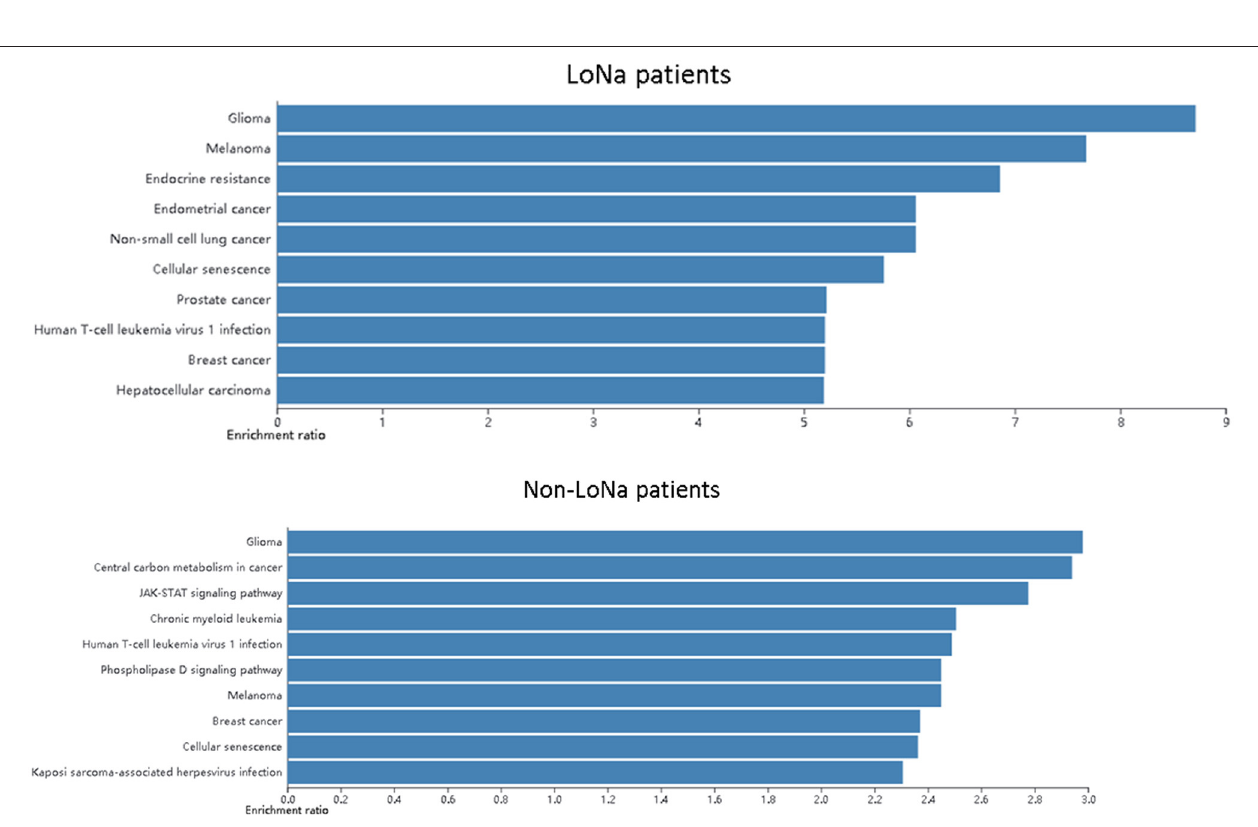
FIGURE 6 | Pathway analysis of LoNa patients and non-LoNa